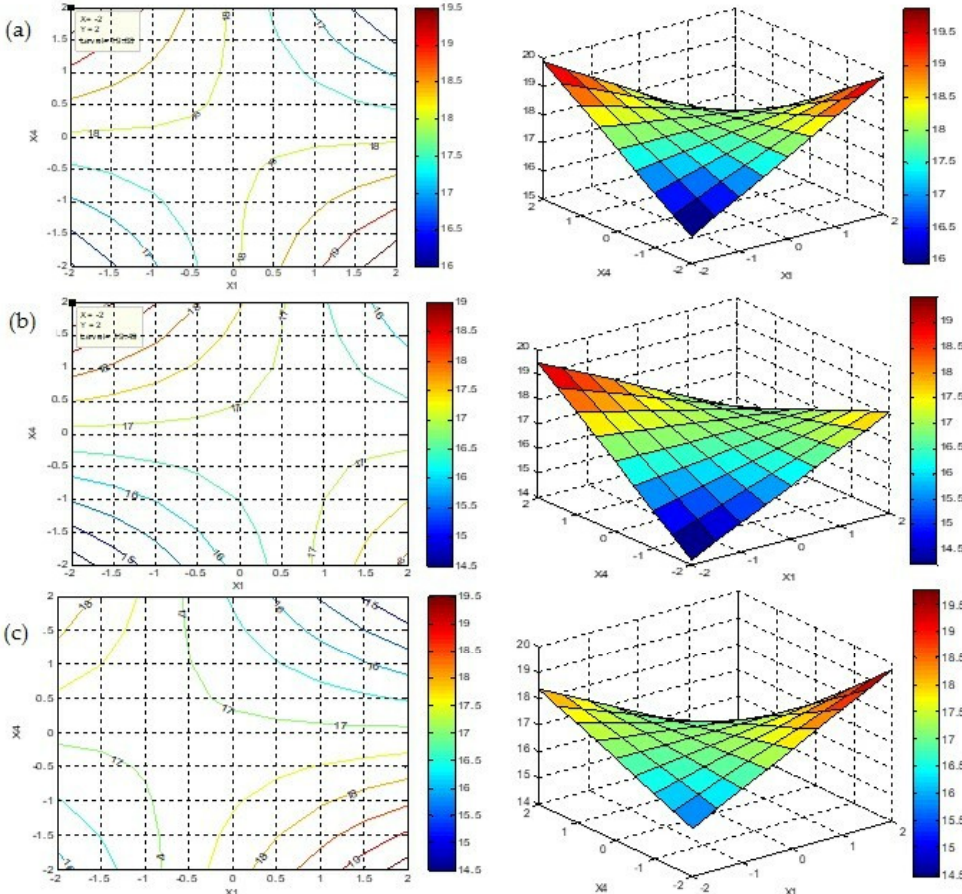
Figure 4. Contour plots and response surface plots for different conditions. ( a ) X 2 = 0, X 3 = 0; ( b ) X 2 = +1, X 3 = +1; ( c ) X 2 = − 1, X 3 = −